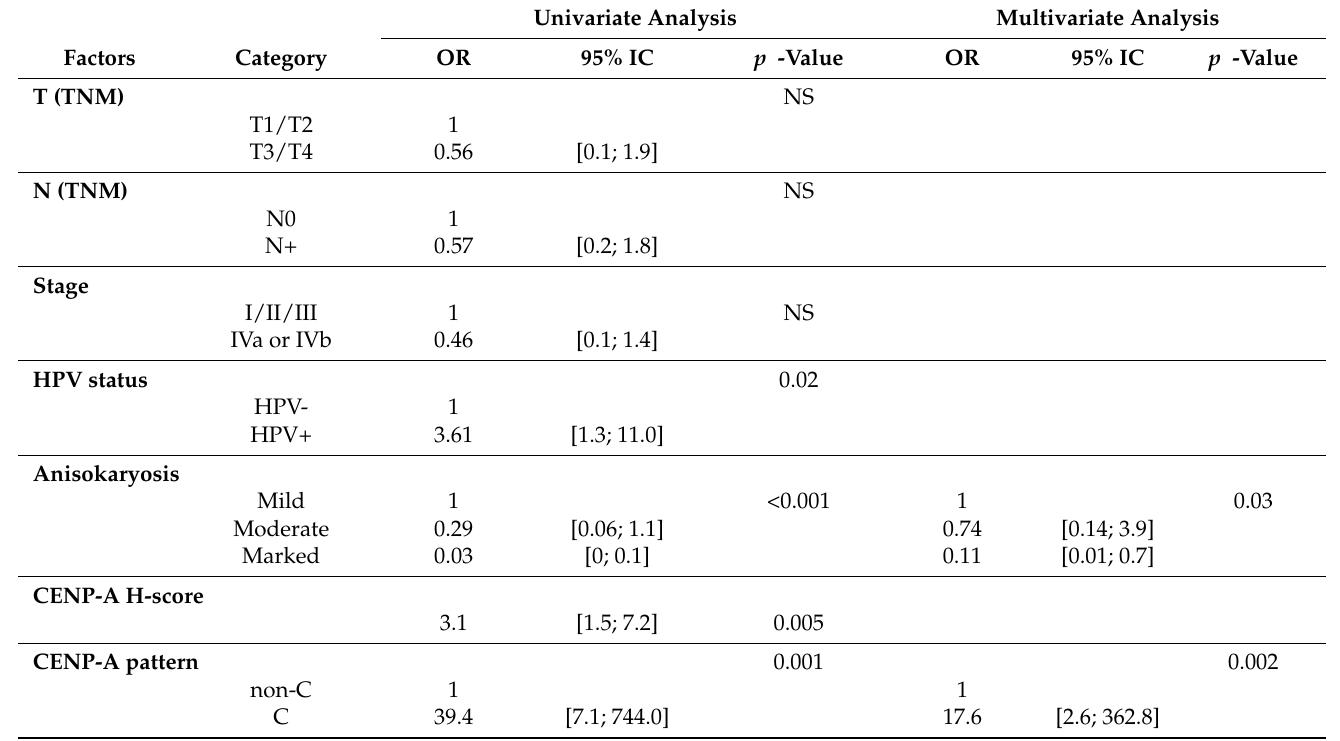
Table 2. Logistic regression to test predictive value for disease